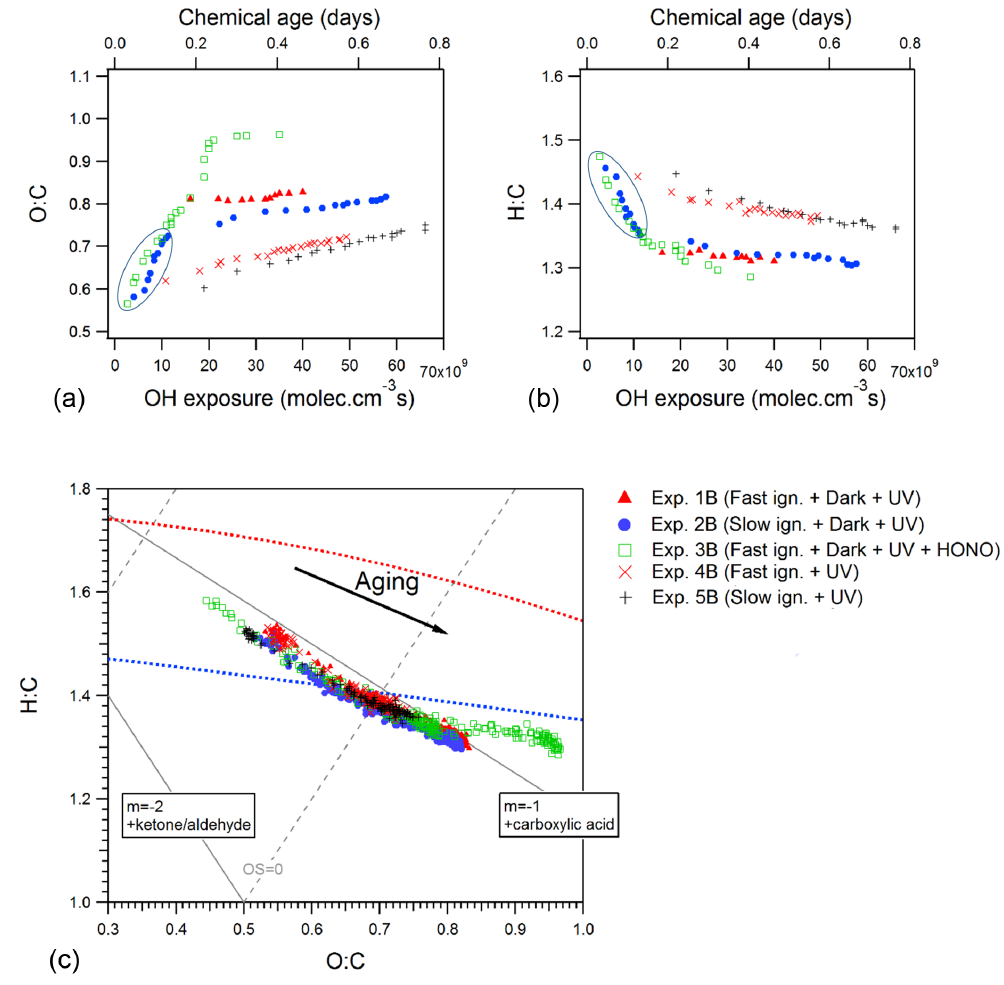
Figure 4. Comparison of OA elemental composition for the second set of experiments (Exp. 1B–5B): OA elemental composition vs. OH exposure (a–b) and van Krevelen diagram (c) . The improved-ambient method from Canagaratna et al. (2015) was applied for the elemental analysis. The dotted lines define the triangular space where ambient OA components are typically located (Ng et al., 2010) and dark aging periods are circled in grey (a–b)